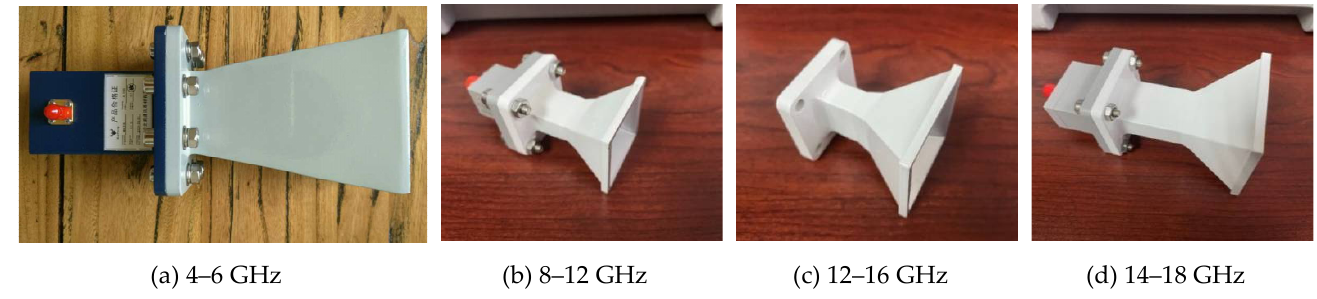
Figure 6. Images of each frequency cone horn antenna.